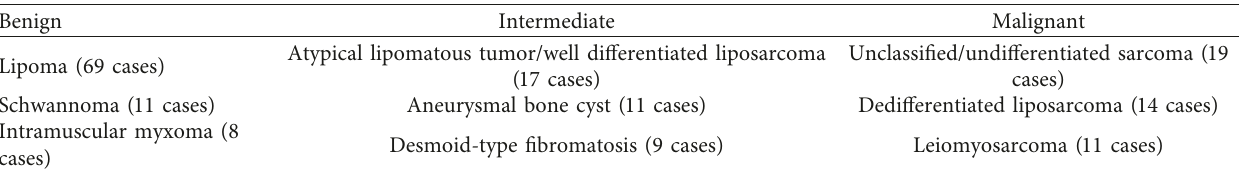
Table 2: Most common diagnoses.